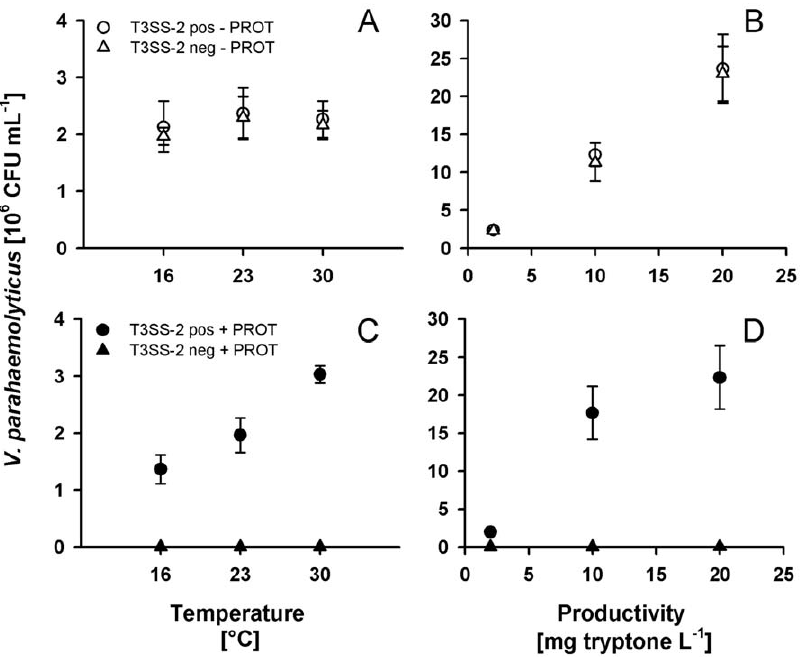
Figure 5. Effects of temperature and productivity on selective enrichment of T3SS-2 positive V.parahaemolyticus . Maximum bacterial abundances of the T3SS-2 positive wild type RIMD2210633 and the T3SS-2 deficient mutant POR3 were determined in the absence (open symbols) and the presence (closed symbols) of the ciliate T. pyriformis . Temperature effects (A and C) were tested using media containing 2 mg tryptone ml 2 1 ; productivity effects were examined at 23 u C. Error bars represent standard deviations (n=4).